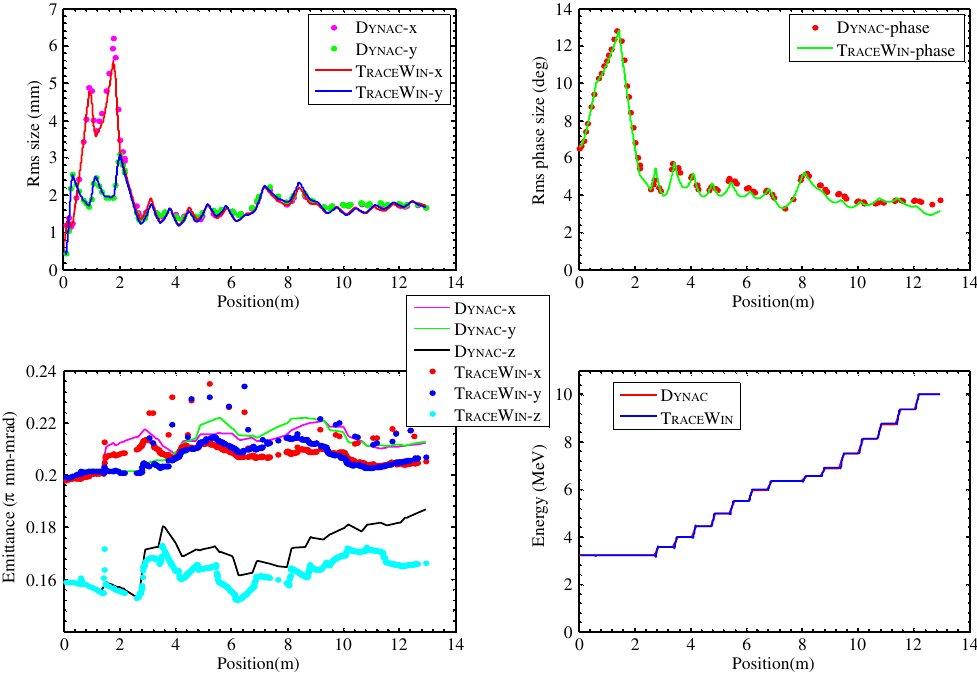
FIG. 17. The benchmarking results for the SC section of Injector I by T RACE W IN and D YNAC : the RMS transverse and longitudinal envelope, emittance and energy evolution along the SC linac.